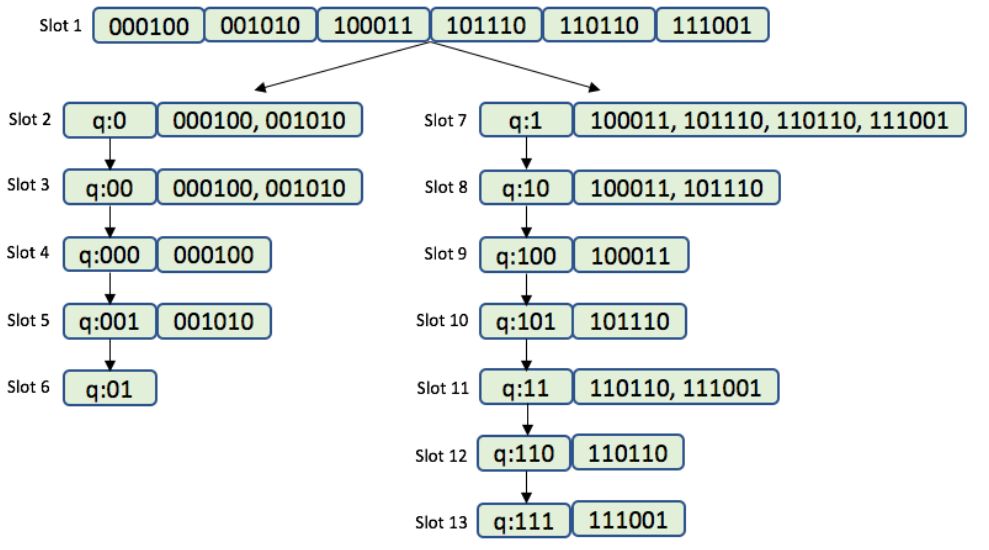
Figure 1. Example of the QT